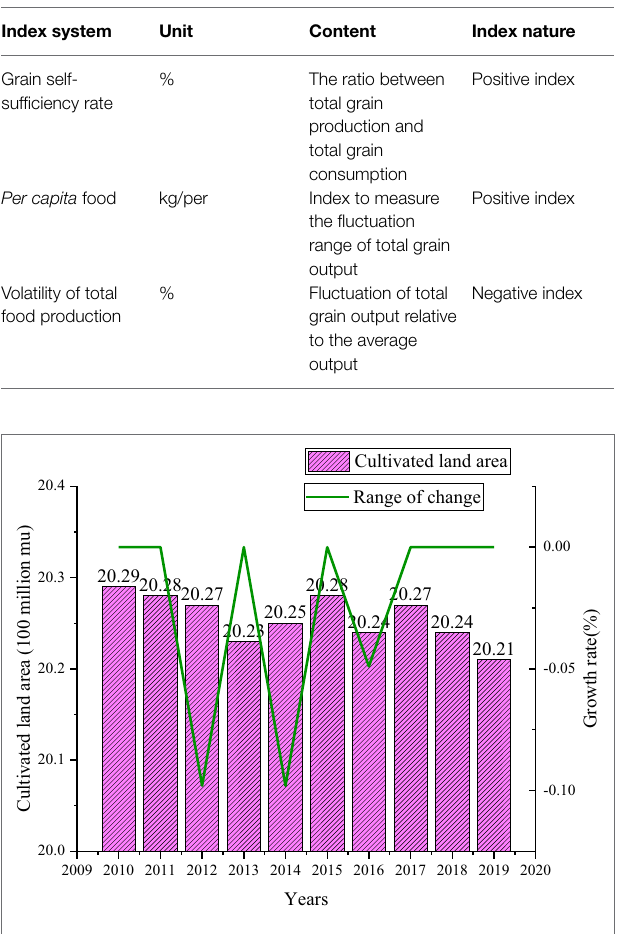
TABLE 1 | Food security evaluation index system.